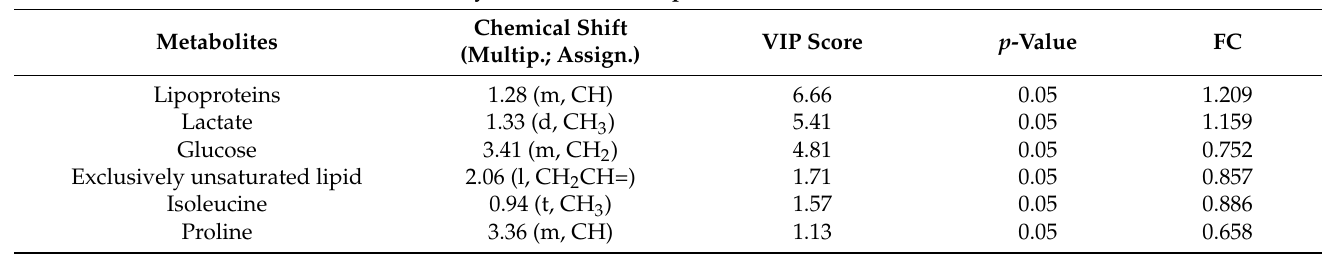
Table 3. List of metabolites identified in different concentrations of refractory and responsive MTLE and their respective chemical shifts elucidated by the highest VIP values (VIP score). The p -values, calculated from the t -test, FC (fold change) are also